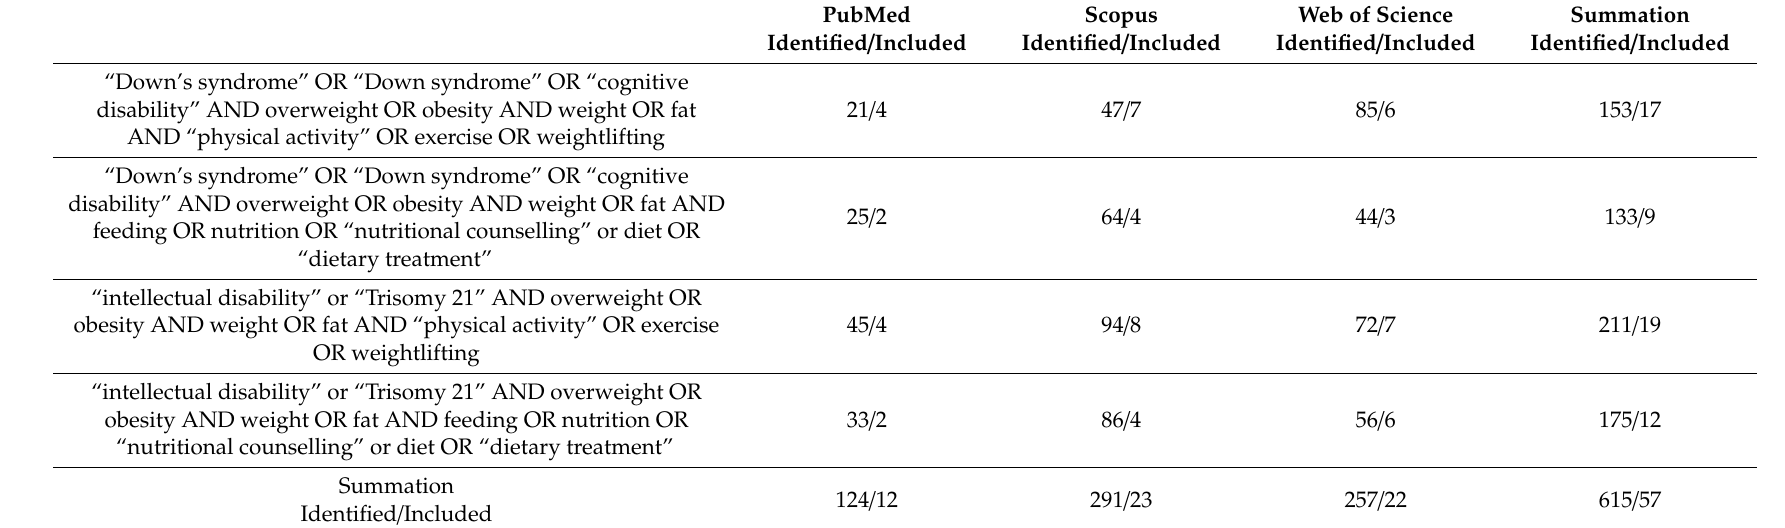
Table 1. Search strategies used to identify and to select clinical trials from January 1997 until December